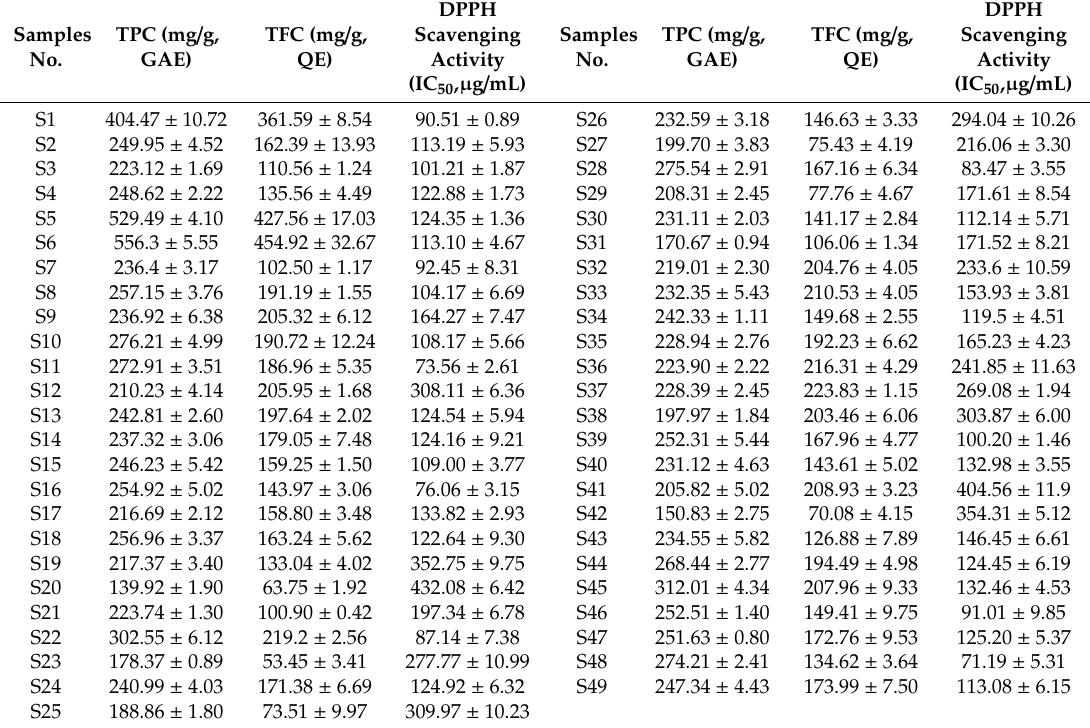
Table 2. Total phenolic acid (TPC) contents, contents of total flavonoids (TFC) and 1,1-Diphenyl- 2-picrylhydrazyl (DPPH) scavenging activity of 49 Chinese propolis. Samples